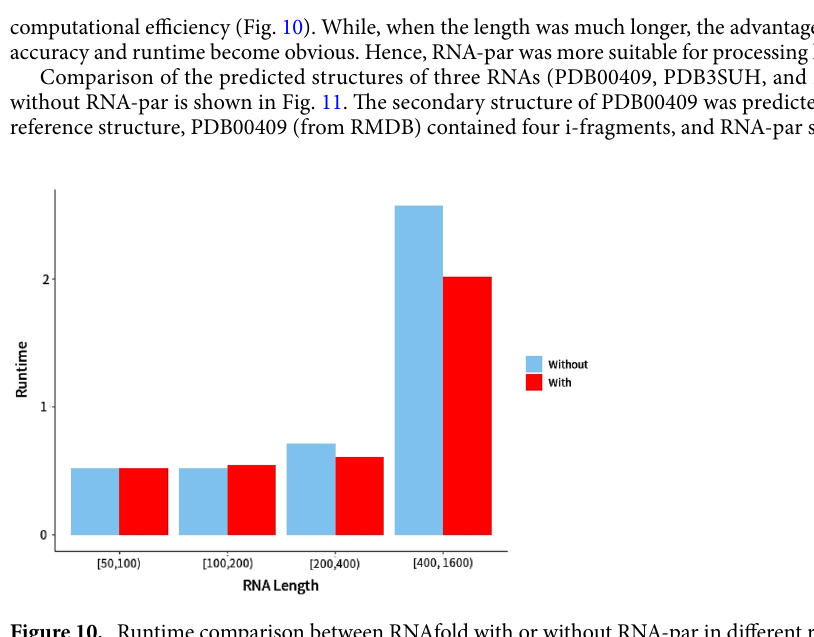
Figure 10. Runtime comparison between RNAfold with or without RNA-par in different ranges of RNA length. The dataset used was TS’ (See Table 1). The unit of measurement for runtime is second. The time of loading deep learning libraries was not taken into account. Our model was built under the framework of keras. In our server, the model of GPU was NVIDIA GeForce RTX 2080 Ti, the model of CPU was Intel(R) Xeon(R) Platinum 8164. Only one GPU and CPU were used. The capacity of the memory was 128